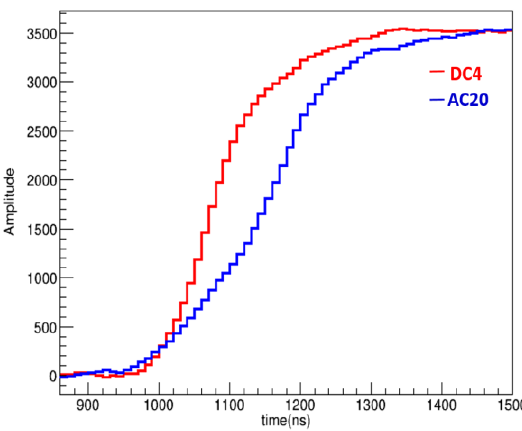
Fig. 4: T10 aligned traces for a middle cut selection (-2.1<Position_X<-1.9) on active region in 2-D image obtained from PSD. Traces of DC4 and AC20 are represented by red and blue color,